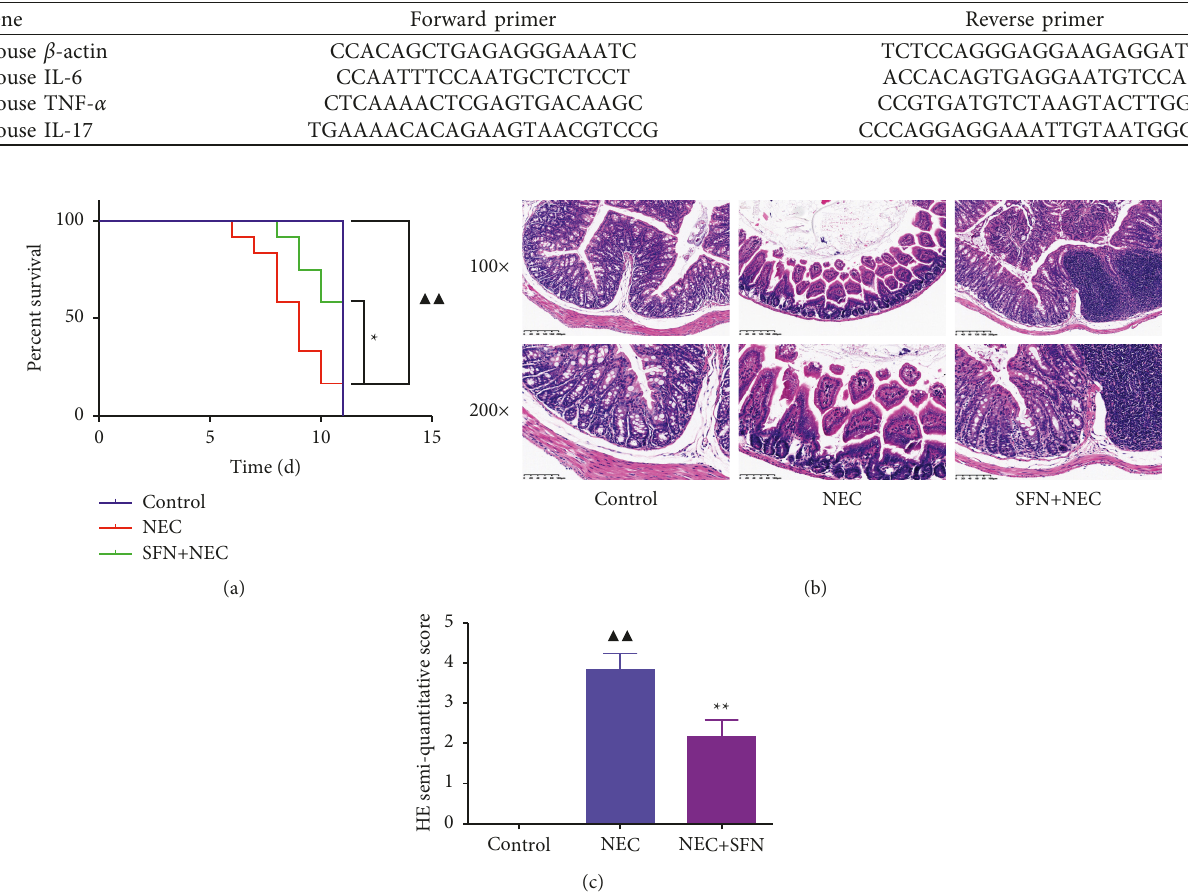
Figure 1: Effects of SFN on survival rate and intestinal histopathological changes in NEC mice. (a) Survival analysis of mice in each group. (b) H&E staining and semiquantitative scoring results of the intestinal tissues of mice in each group, n � 6. NEC, necrotizing enterocolitis; SFN, sulforaphane. Compared with the control group, ▲ P < 0 . 05, ▲▲ P < 0 . 01; compared with the NEC group, ★ P < 0 . 05, ★★ P < 0 . 01. Data represent the mean ±